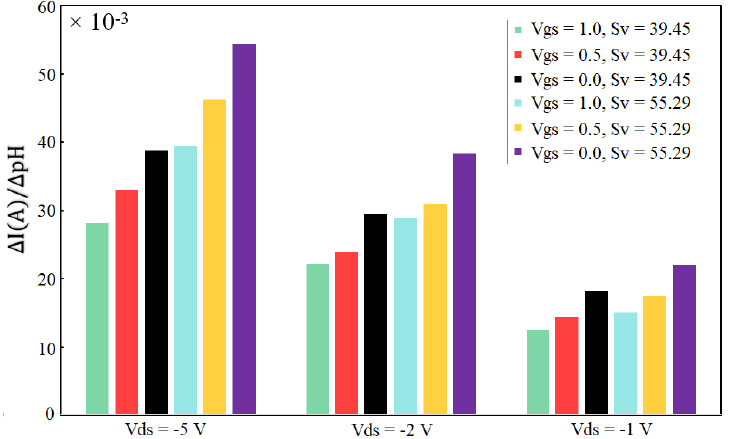
Figure 12. The effect of gain on the current sensitivity for different values of surface charges due to pH variations. Sv is the voltage sensitivity of sensor with unit of mV/pH.